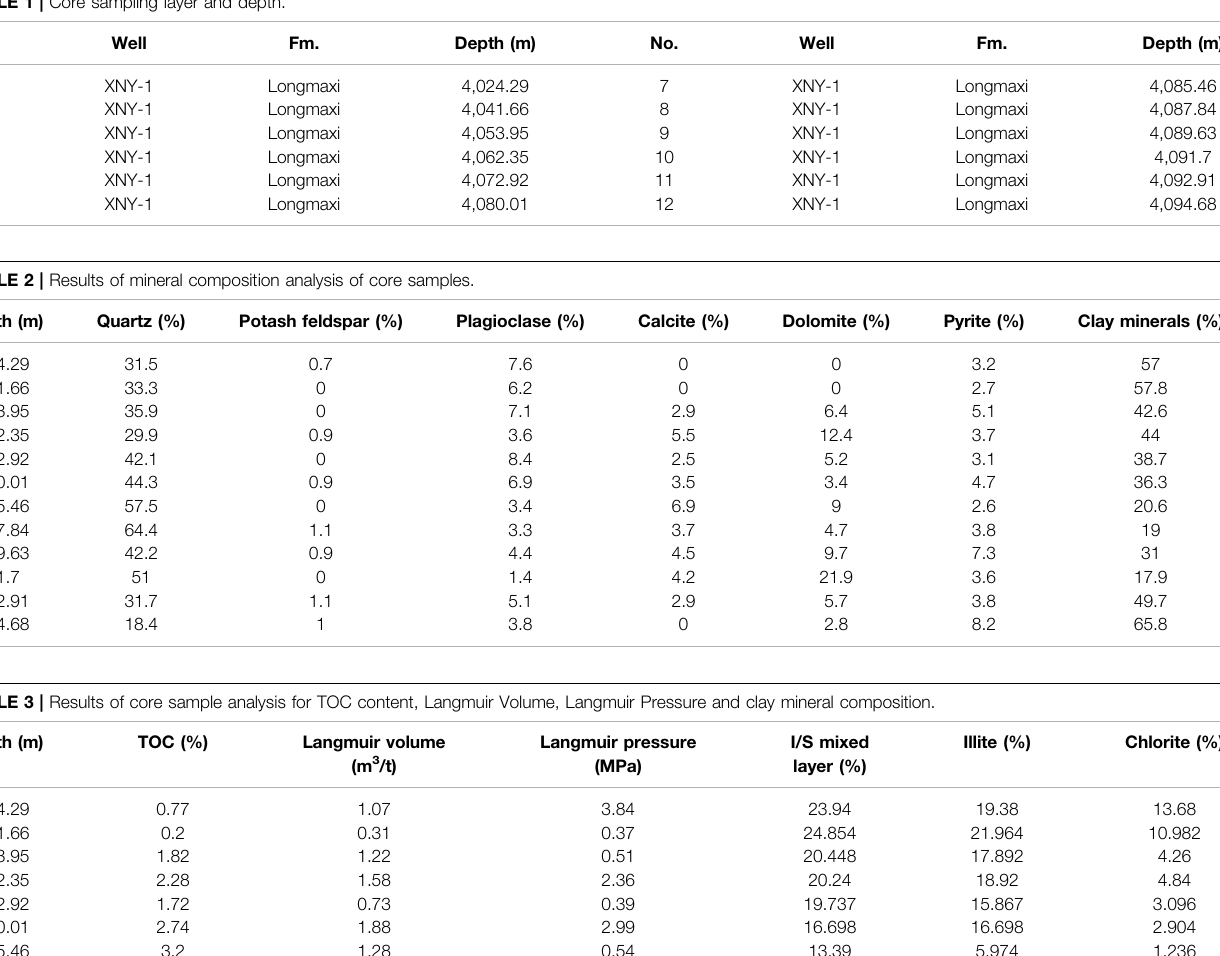
TABLE 1 | Core sampling layer and depth. No. Well Fm. Depth (m) No.